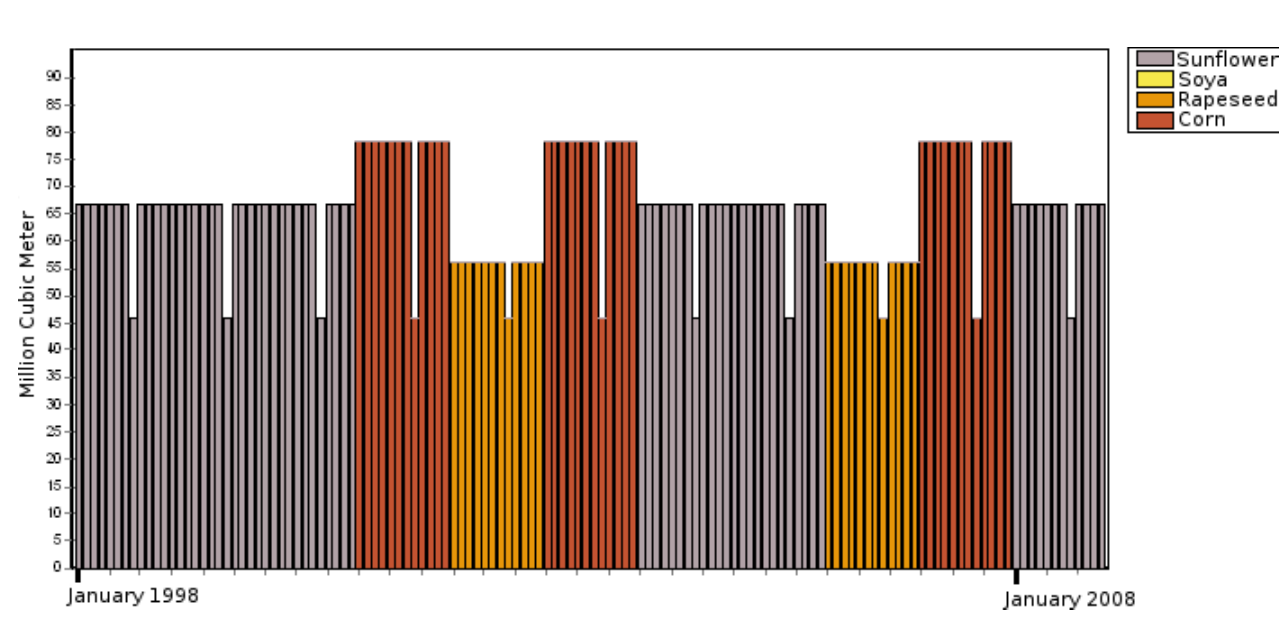
Fig. 6 . Evapotranspiration due to crop